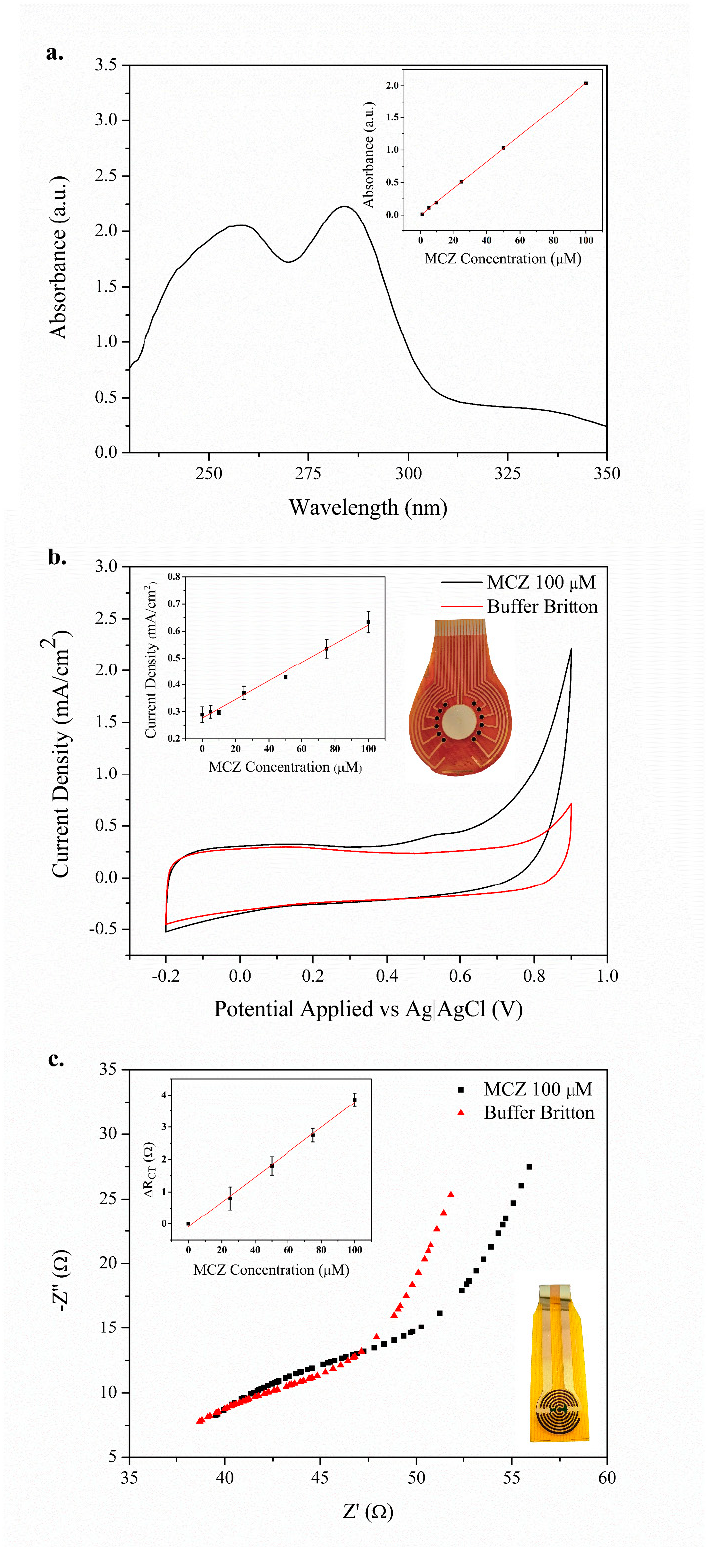
Figure 5. Quantification of mancozeb (inset: Calibration curves) in solution using: ( a ) UV-vis spectrophotometry, ( b ) electrochemical oxidation by cyclic voltammetry method, and ( c ) electrochemical impedance spectroscopy. Specific electrodes were fabricated regarding the technique (see insets of Figure 5b,c).